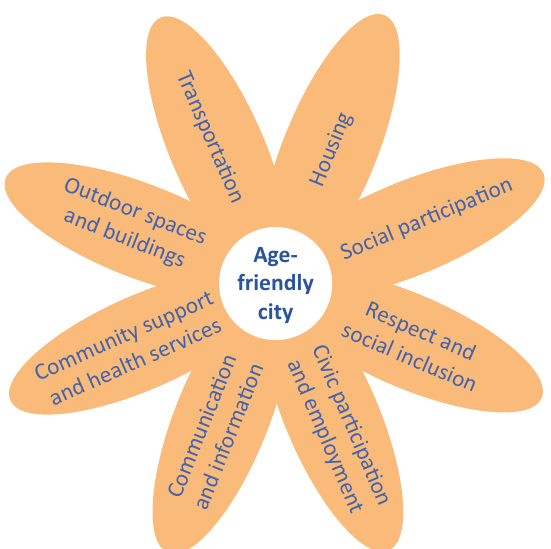
Figure 1. The age-friendly city model according to WHO